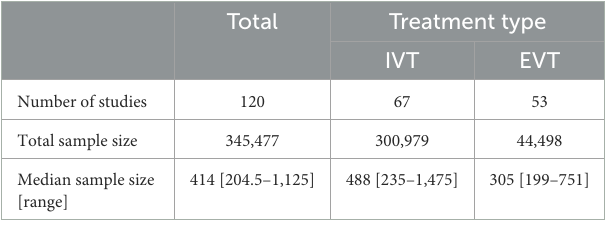
TABLE 1 Baseline characteristics of included studies.